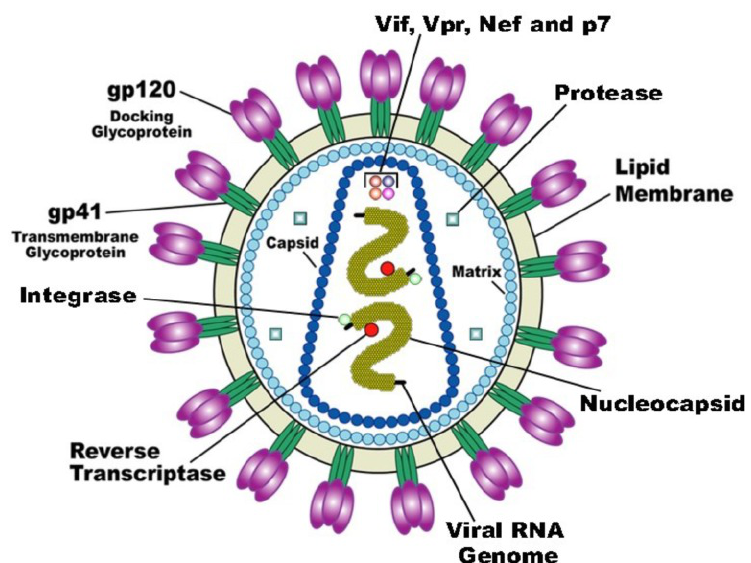
Figure 1. The structure of the HIV virion [8].